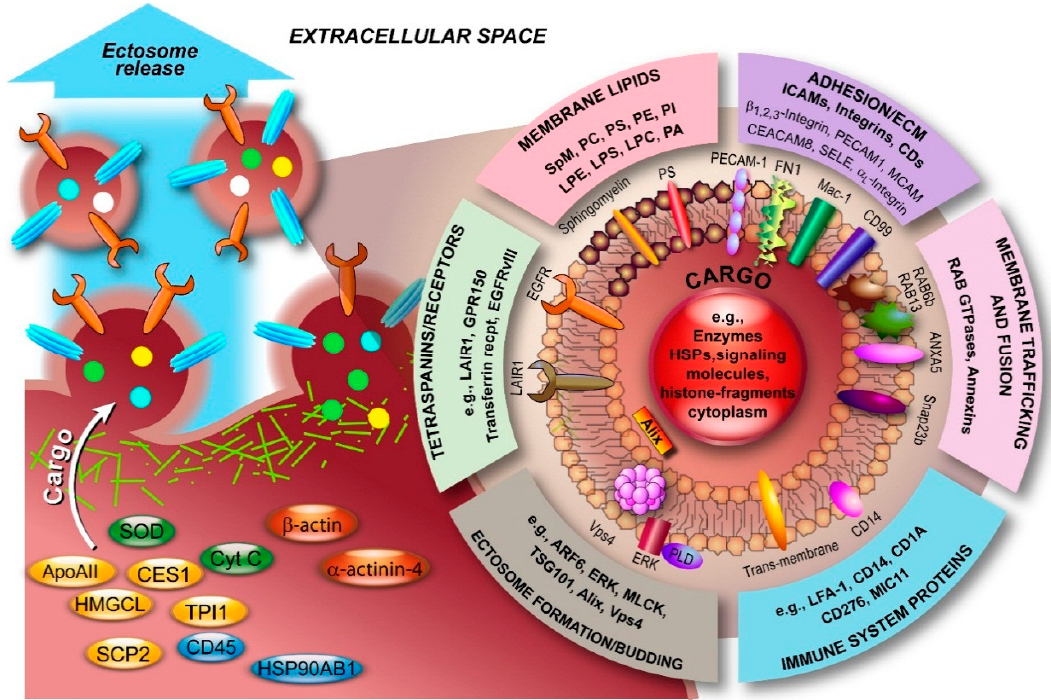
Figure 5. Molecular composition of ectosomes. Ectosomal membranes consist of various classes of lipids. Furthermore, in recent years, numerous components with diverse functions have been identified, predominantly from blood, immune and endothelial cells, and atherosclerotic plaques.